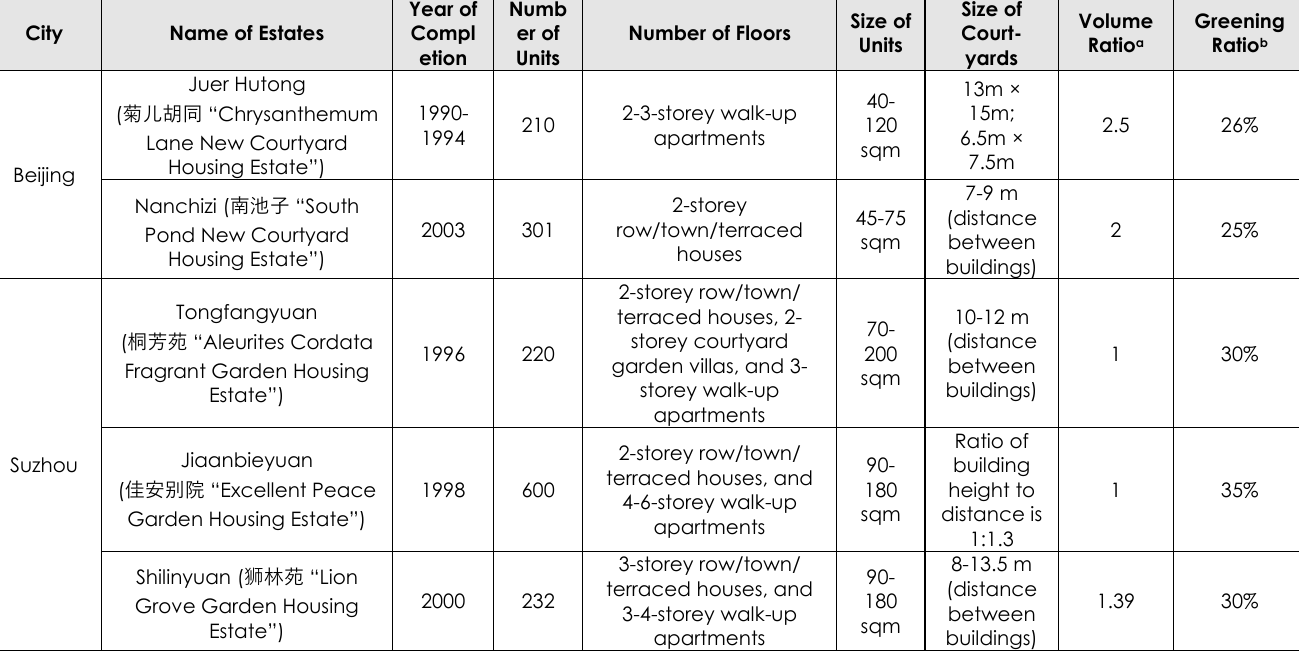
Table 2. First-generation Chinese-style new courtyard housing estates constructed in China since the 1990s.